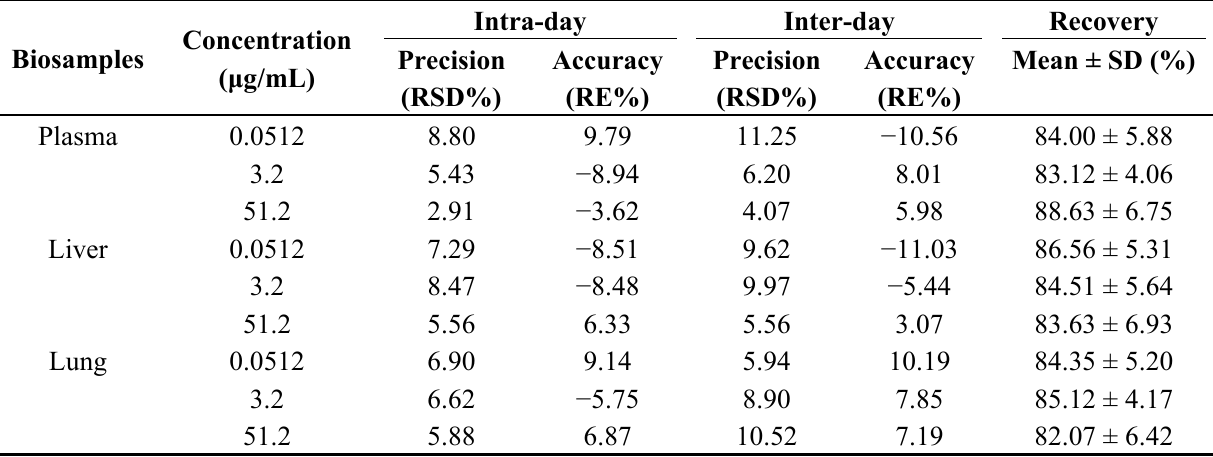
Table 2. Accuracy, precision and recovery of the method used for determination of PD in rat plasma and tissue samples ( n =